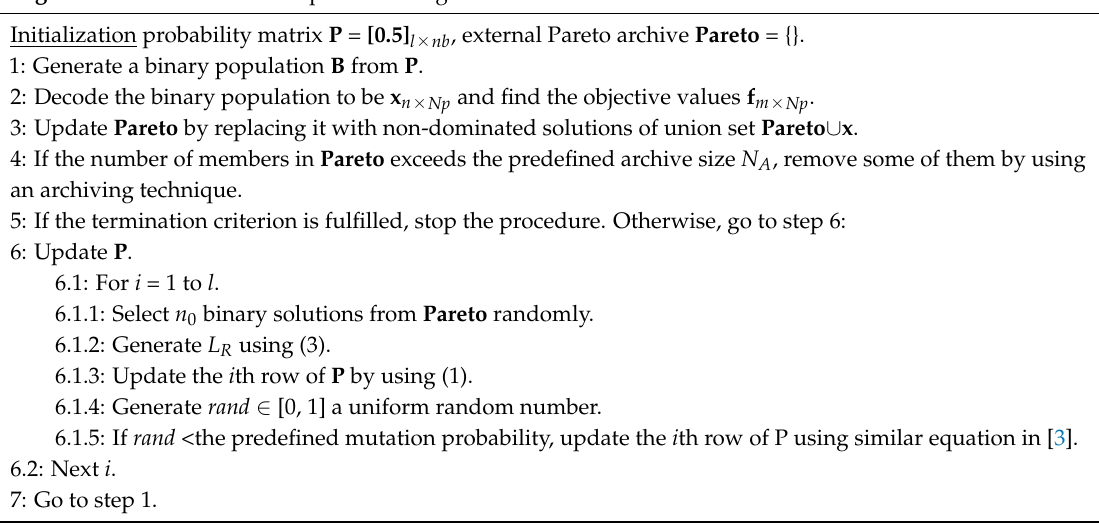
Algorithm 3. MPBIL with adaptive learning rate.